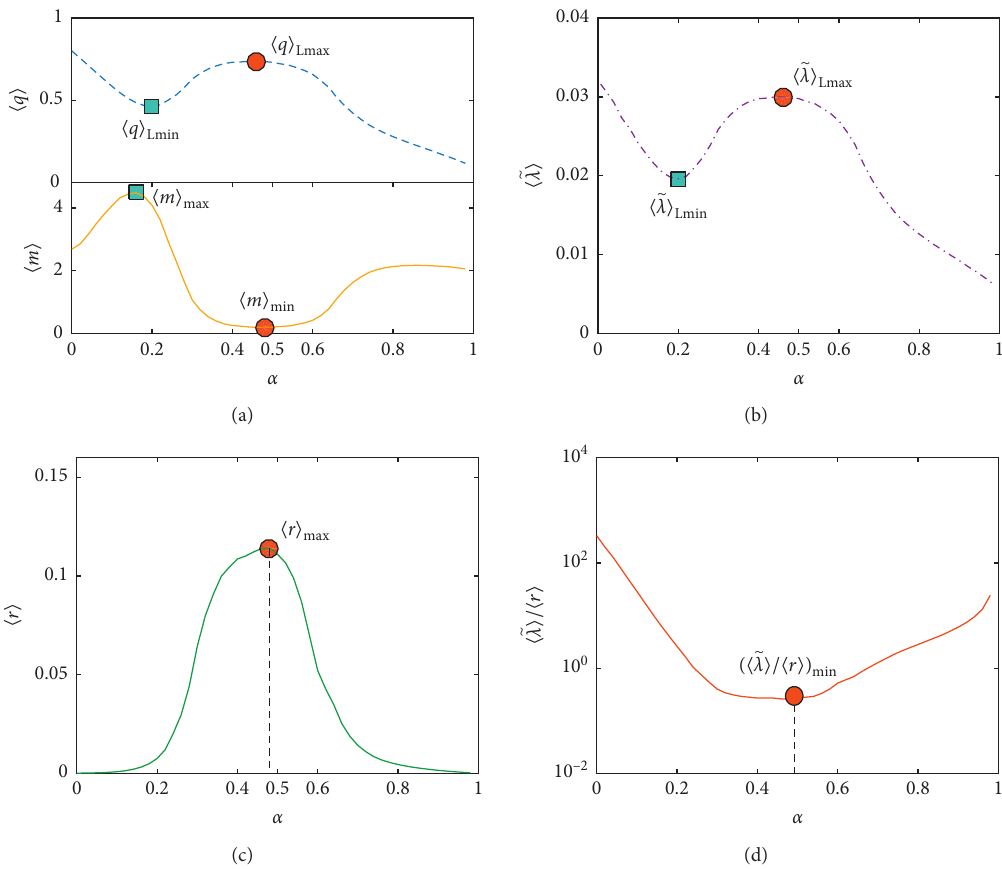
Figure 5: Plots of the critical parameters versus α at fixed time t � 200 and basic infection rate λ � 0 . 04. (a) Top pane: the average donation rate 〈 q 〉 as a function of α . Bottom pane: the average number of infected neighbors of all nodes 〈 m 〉 as a function of α . (b) The average infection rate 〈 􏽥 λ 〉 as a function of α . (c) The average recovery rate 〈 r 〉 as a function of α . (d) Plots of average effective infection rate 〈 􏽥 λ 〉 / 〈 r 〉 as a function of α . The results of the simulations are obtained by averaging over 300 realizations.